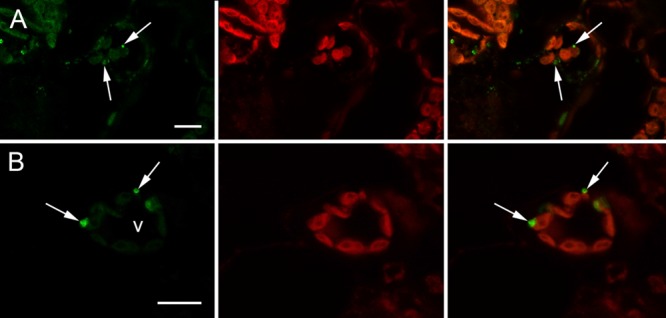
Immunolocalization of H5-zein in N. benthamiana leaves by confocal microscopy. (A) Abundant H5-zein protein bodies (PBs) can be observed in mesophyll cells (arrows). (B) H5-zein PBs are 1–2 μm in diameter and can be found in the cytoplasm between the chloroplasts (arrows). The left panel shows the detection of the fusion protein. The middle panel shows autofluorescence of the chloroplasts. The right panel shows the overlay pictures. Abbreviations: v, vacuole. Bars = 10 μm.